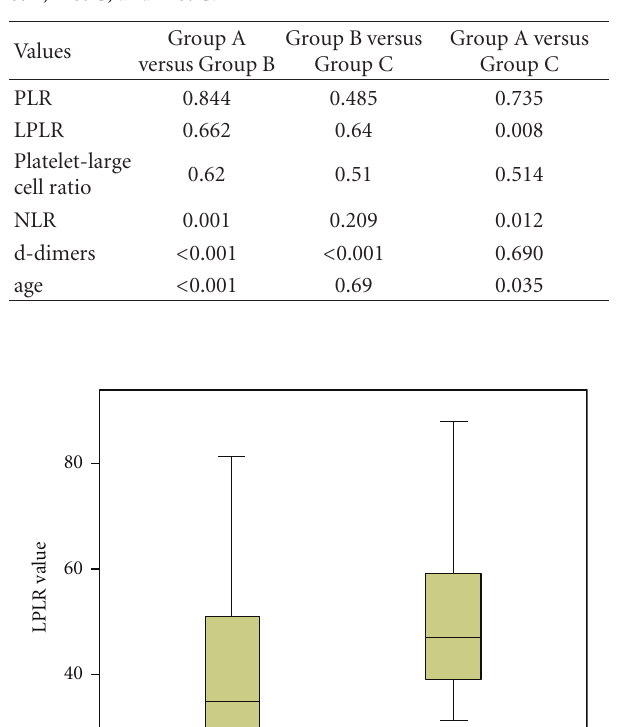
Table 2: Comparison of the evaluated parameters within Groups A & B, B & C, and A & C.